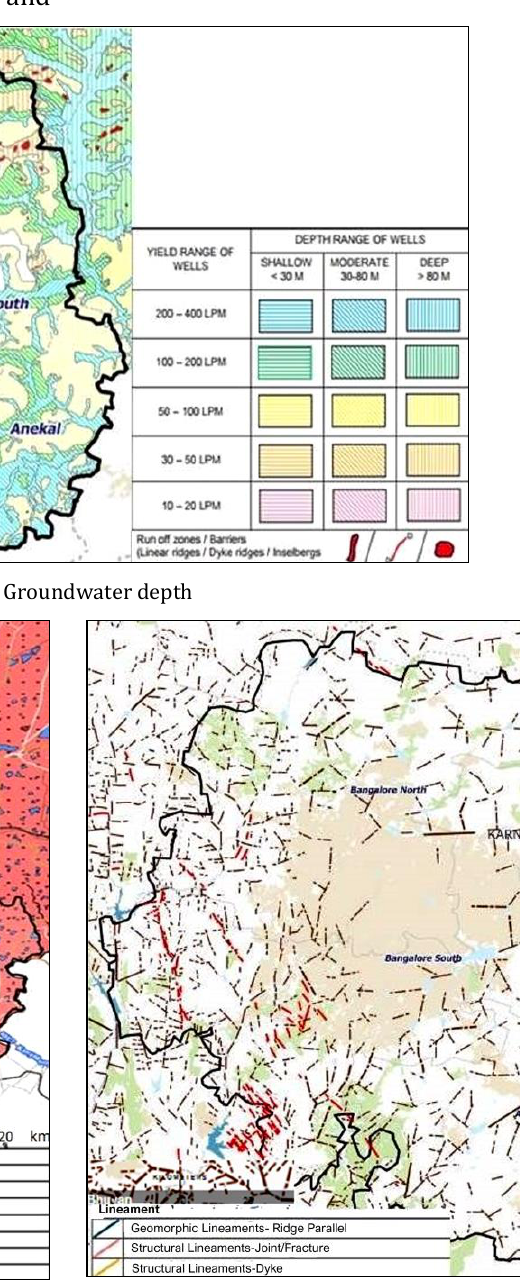
Fig. 5. Geomorphological map of the study area Fig. 6. Lineament map of the study